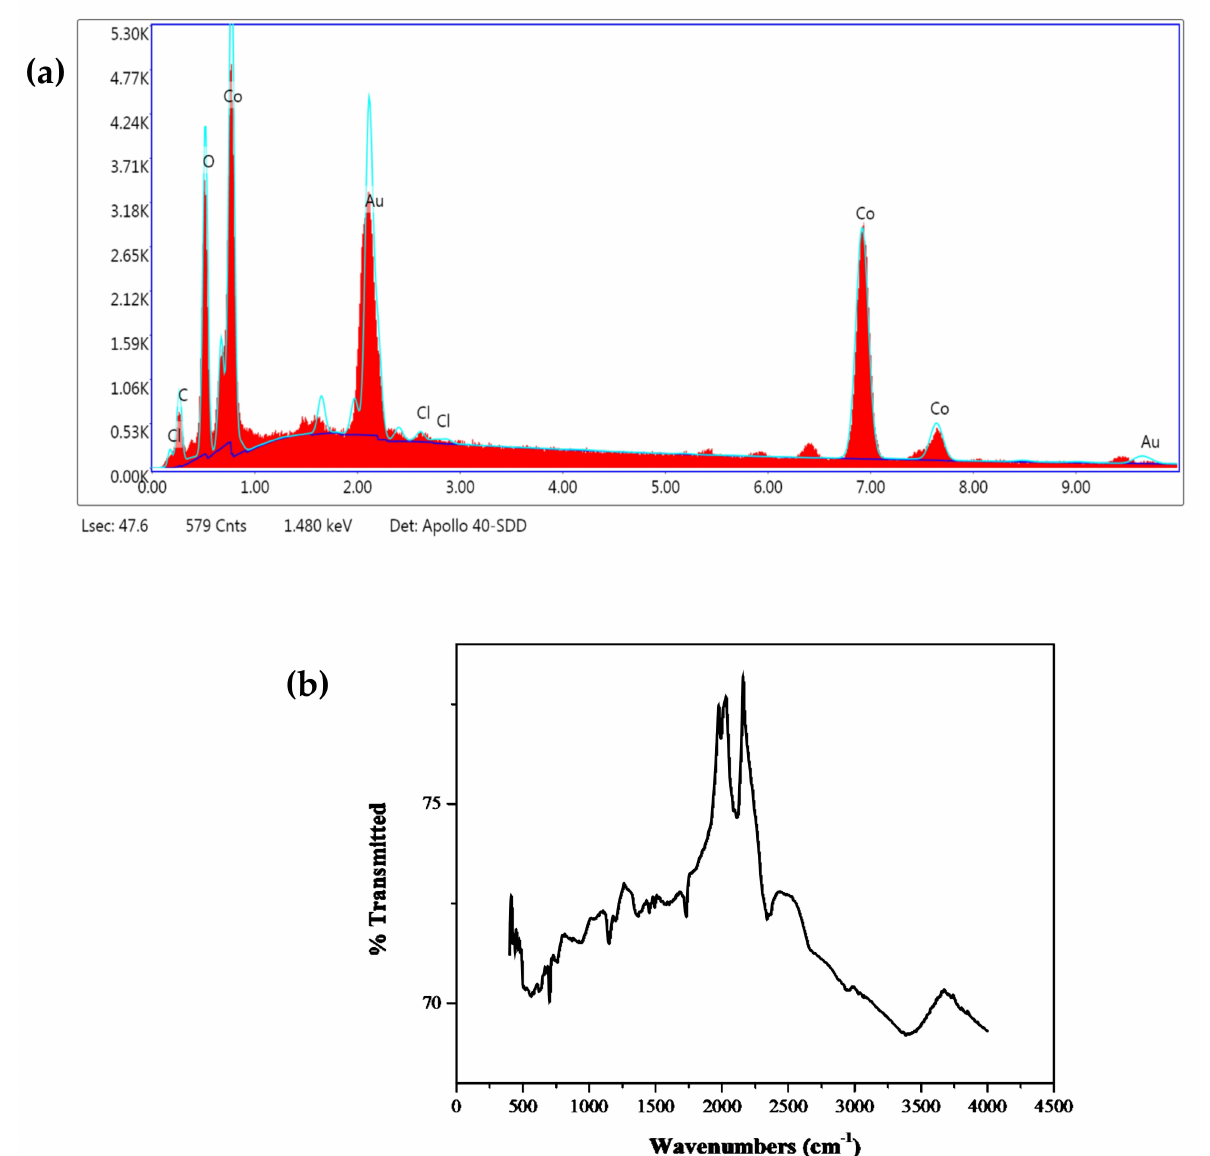
Figure 2. Analysis of the electrode modified with GO/Co/chitosan in the developed biosensor: ( a ) EDS of GO/Co/chitosan composite; ( b ) FT-IR spectra of GO/Co/chitosan composite. Detection condition is HV 10.00 KV; magnification at 1000 ×